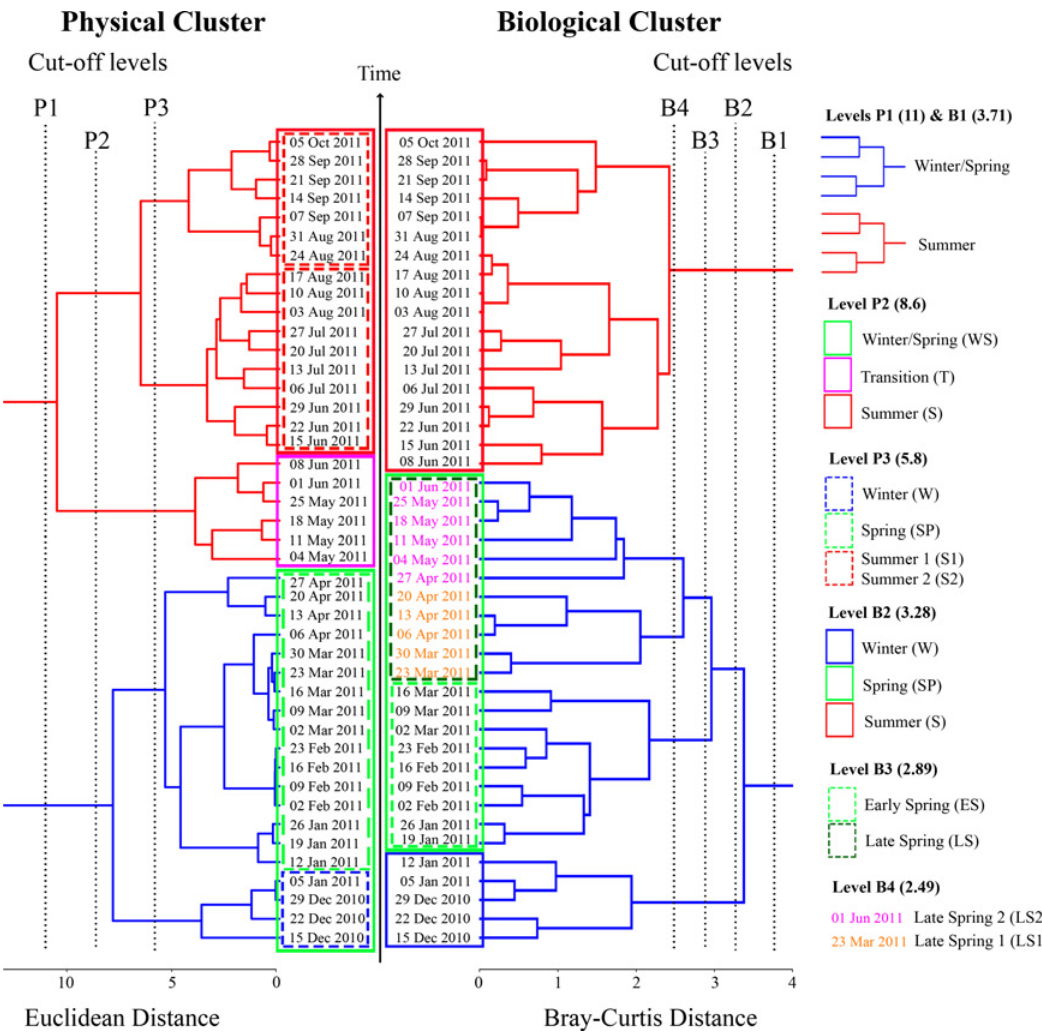
Fig 4. Cluster analyses of physical (temperature and salinity, left) and biological (PEC biovolumes, right) data. Three significant clustering levels were identified for the physical characteristics of the water column: level P1, (cut-off = 11, red and blue branches of the tree); level P2 (cut-off = 8.6, solid-line coloured rectangles); level P3 (cut-off = 5.8, dashed-line coloured rectangles). Four significant clustering levels were identified for the biological data: level B1 (cut-off = 3.71, red and blue branches of the tree); level B2 (cut-off = 3.28, solid-line coloured rectangles); level B3 (cut-off = 2.89, dashed-line rectangles) which clustered 4 groups; level B4 (cut-off = 2.89, coloured fonts) which clustered 5